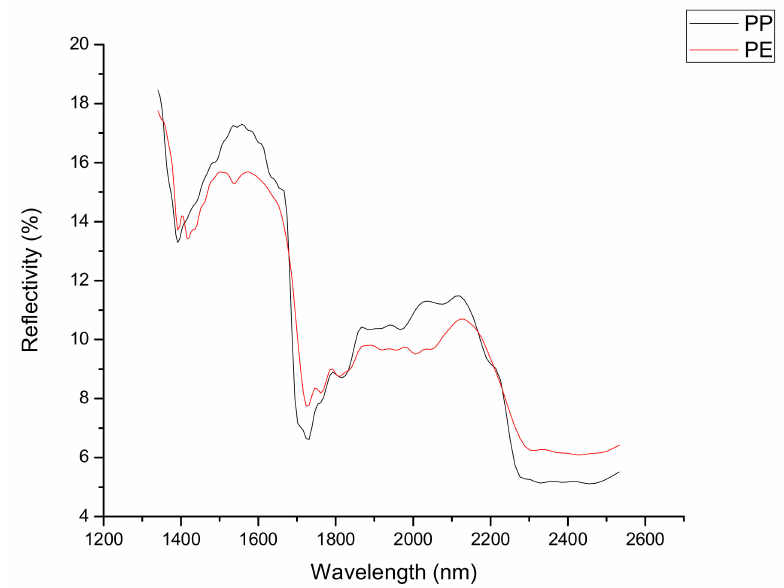
Figure 2. Average spectra of polypropylene (PP) and polyethylene (PE) pellets, taken with Neospectra instrument. The two spectra are very similar in almost the entire spectral region considered and show only slight differences around 1400 nm.